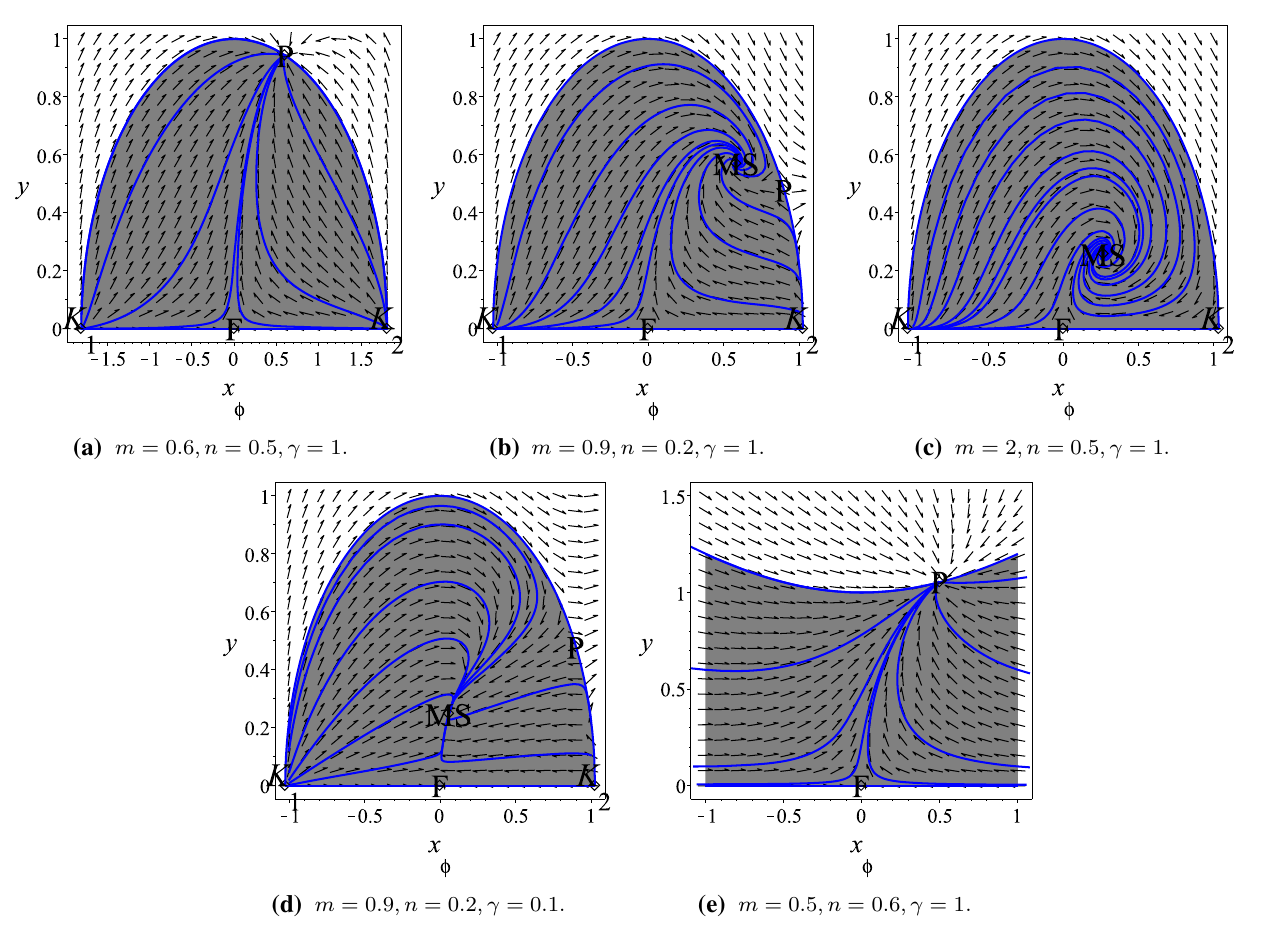
Fig. 1 Some orbits in the phase plane of the system (13)–(14) for five choices of the parameters